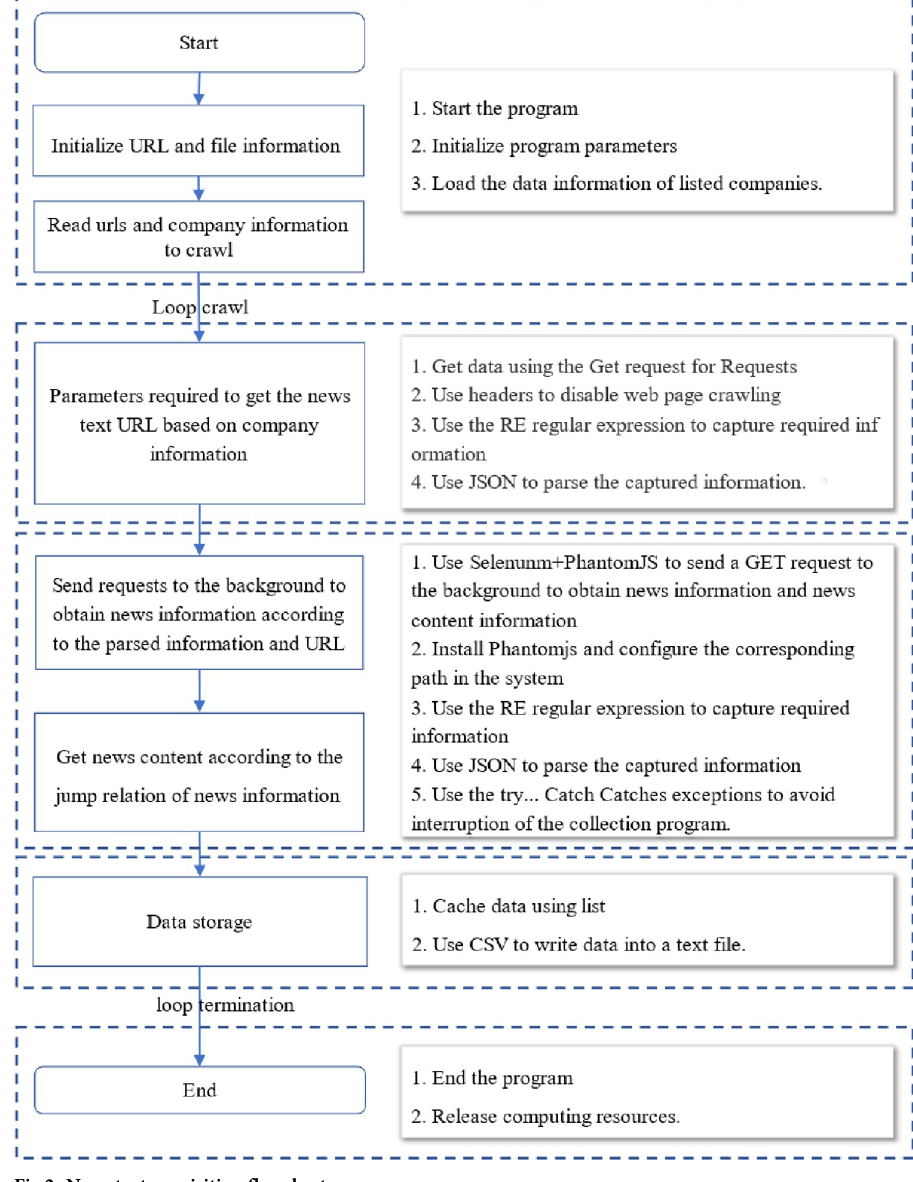
Fig 2. News text acquisition